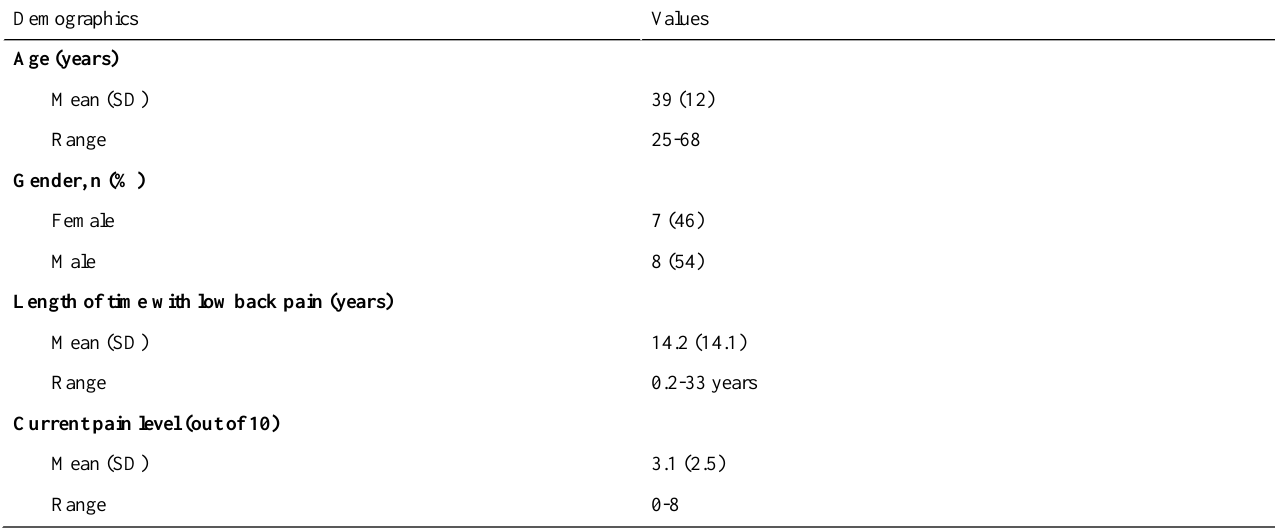
Table 1. Demographic characteristics of the study